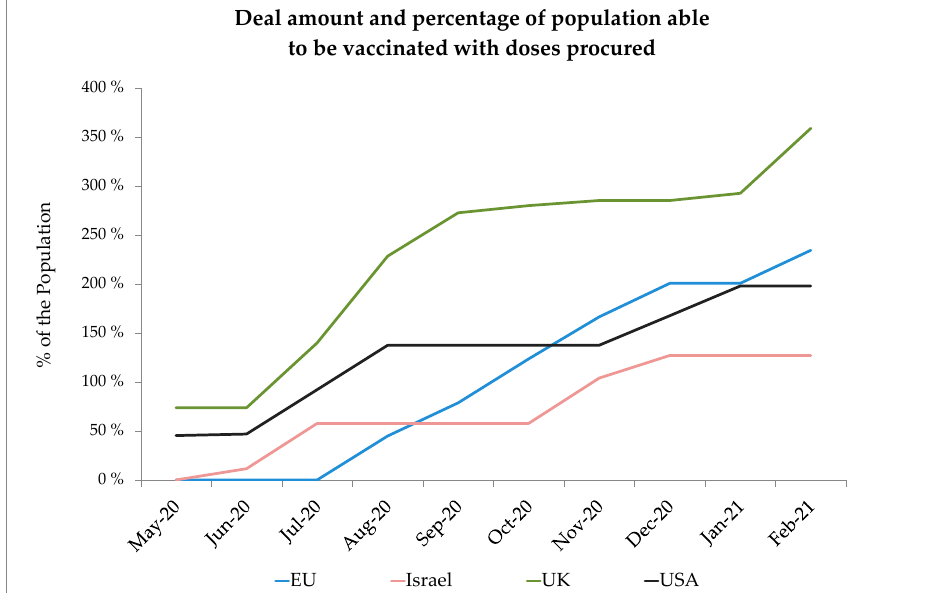
Figure 1. Deal amount and proportion of the population able to be vaccinated per 16 February 2021 (Sources [3,4]).